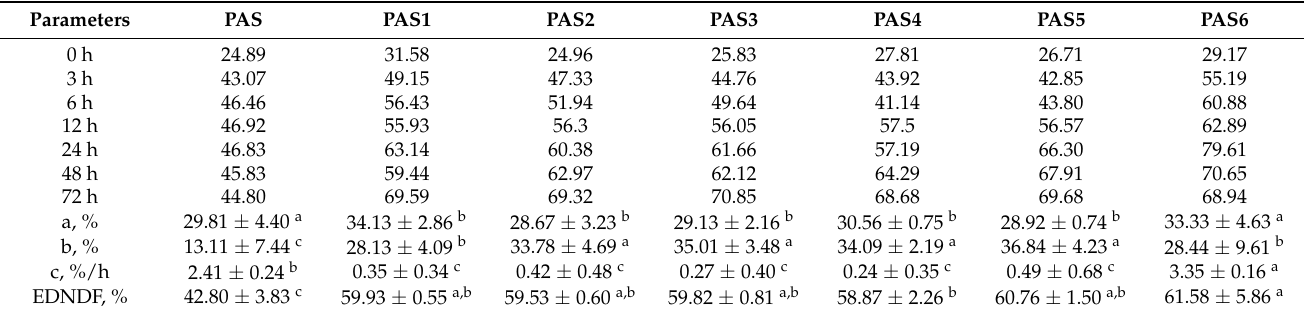
Table 4. Percentage neutral detergent fiber (NDF) disappearance at different incubation periods and the effective degradability of neutral detergent fiber of in vitro-incubated pineapple waste silage with or without proteolytic